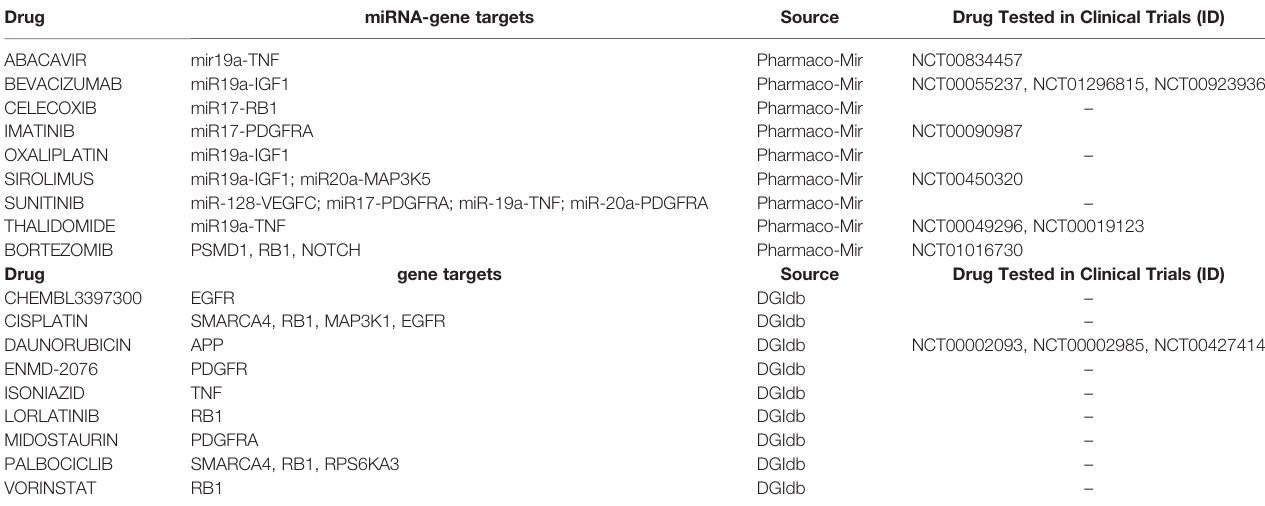
TABLE 1 | Drug-associated to miRNA-gene pairs (upper half of the table) or genes (bottom half of the table) obtained from the lncRNA-miRNA-mRNA